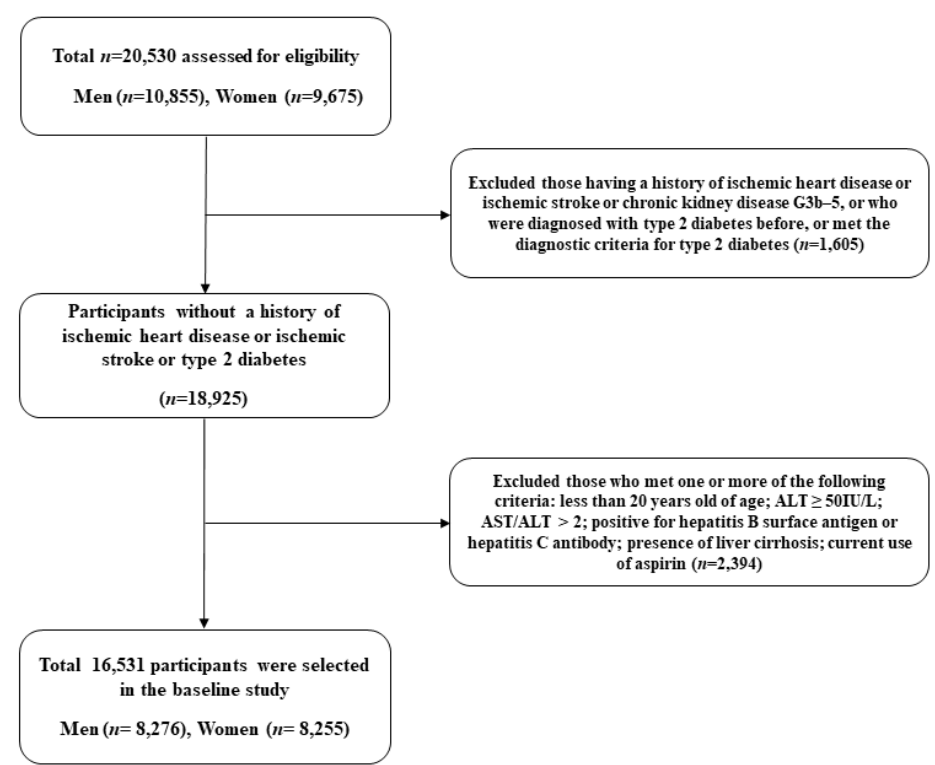
Figure 1. Flow chart of the study population selection.